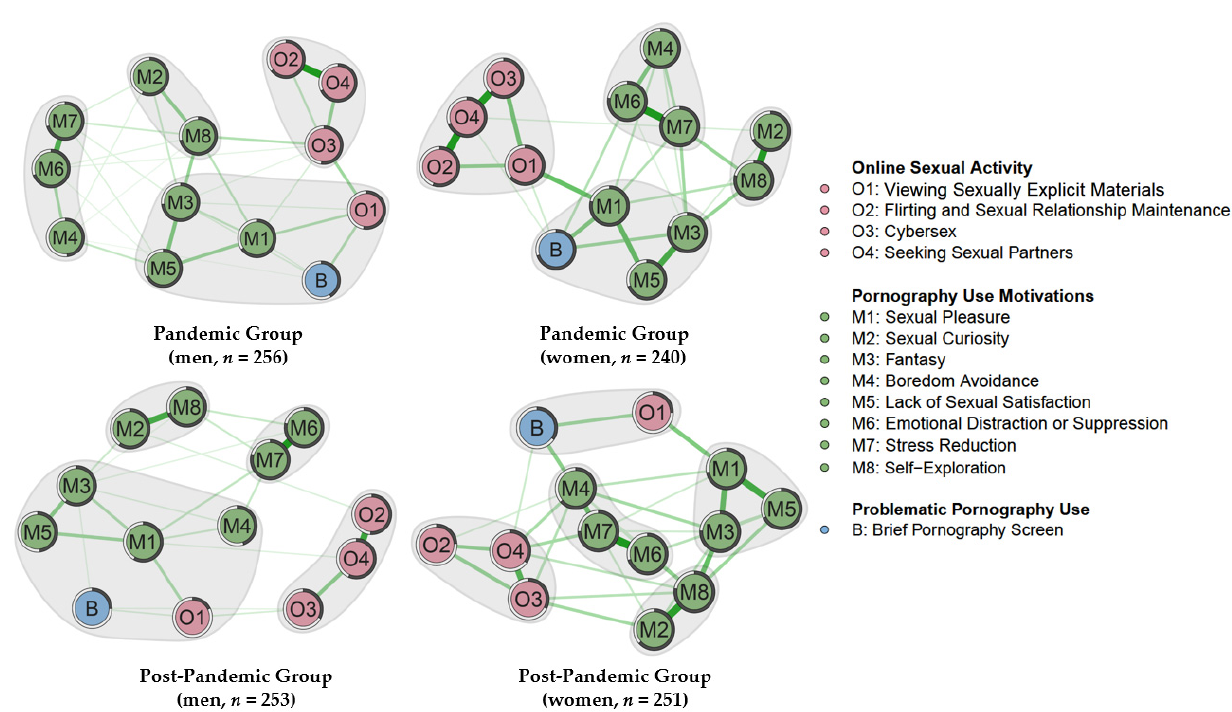
Figure A3. Community of nodes based on spinglass algorithm, visualized on the MGM networks by gender.